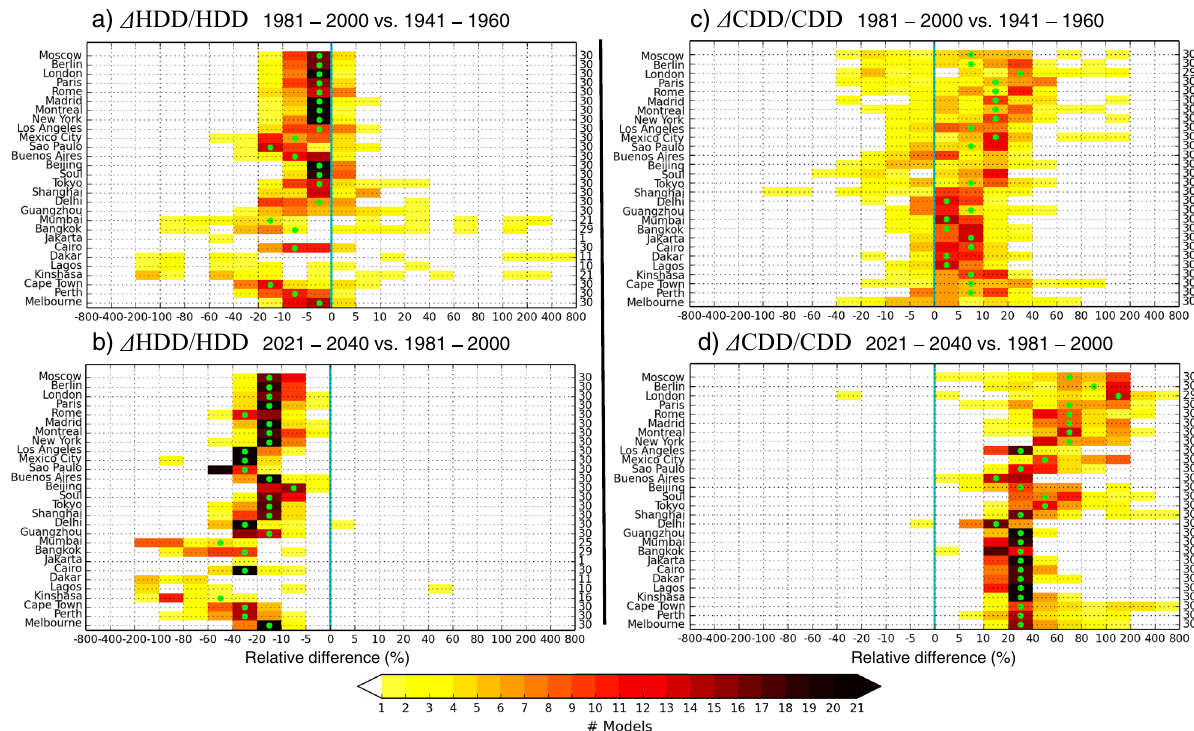
Fig. 3 Inter-model variability of climate-driven trends in energy demand for heating and cooling buildings at selected cities. Trends are expressed as relative differences in annual Heating Degree-Days (HDD) and Cooling Degree-Days (CDD), calculated for each of the 30 CMIP5 simulations. Relative difference in HDD ( Δ HDD/HDD) between the ( a ) 1981 – 2000 and 1941 – 1960 averages, and ( b ) the 2021 – 2040 and 1981 – 2000 averages; relative difference in CDD ( Δ CDD/CDD) between the ( c ) 1981 – 2000 and 1941 – 1960 averages, and the ( d ) 2021 – 2040 and 1981 – 2000 averages. Differences are given in % relative to the earlier period. Projections are based on the RCP8.5 scenario. The color bar denotes the number (#) of models in each range of relative change. The multi-model mean falls in the range marked by the green dots. Numbers on the right indicate the number of models for which the difference between the two periods is signi fi cant. The vertical blue line marks